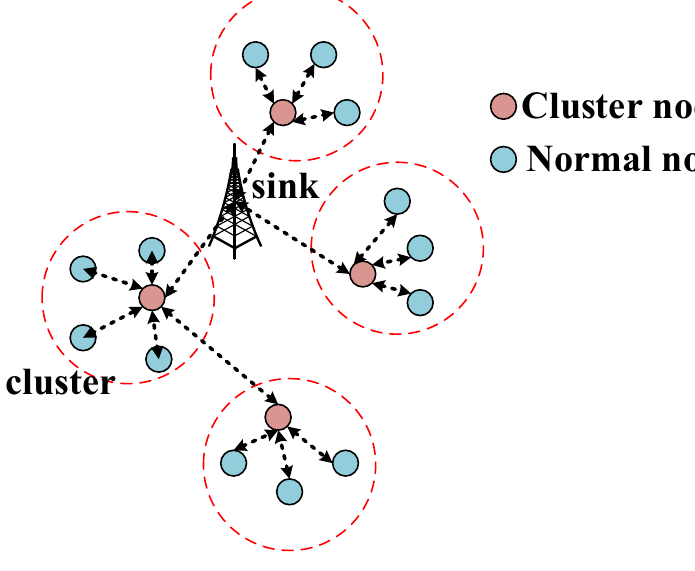
Figure 1. Clustered-based WSN.